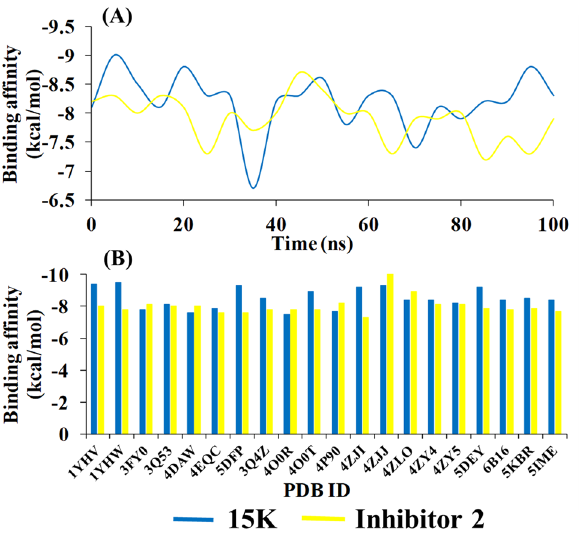
Figure 9. Binding energy values of 15K and inhibitor 2 docked against multiple PAK1 snapshot conformers generated by 100 ns MD simulation ( A ) and PAK1 conformers retrieved from the RCSB protein data bank ( B